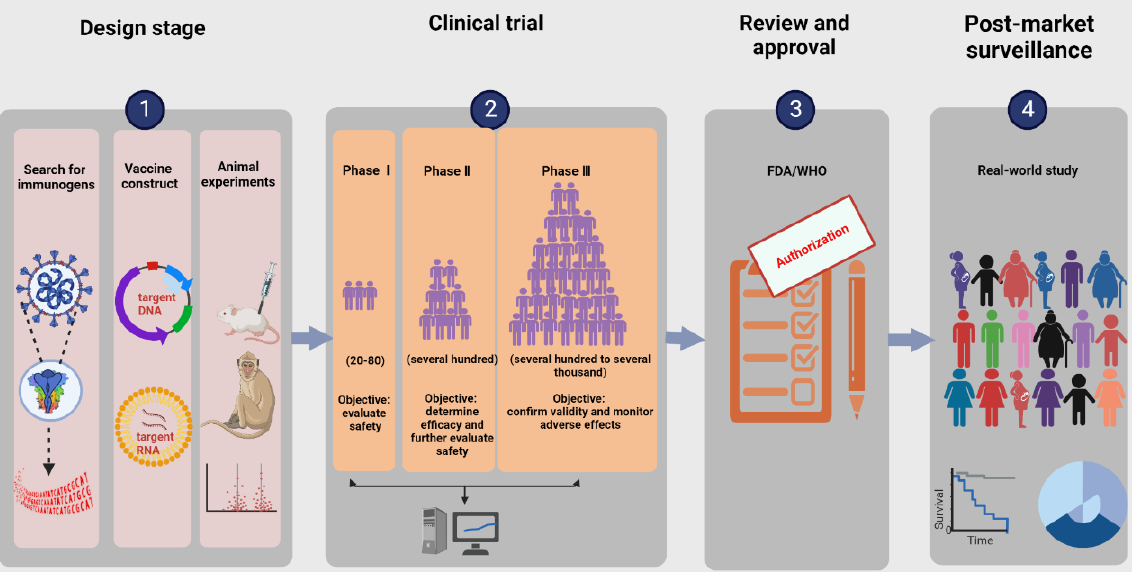
Figure 1. Illustration of the research and development process for nucleic acid vaccines. The proce- dure involves an early design stage, clinical trial stage, review and approval stage, and post-market surveillance. The early design stage generally consists of searching for immunogens, designing vaccine structures, and determining toxicological effects and immune effects in animal models. The clinical trials mainly include phases I–III, targeting primarily practical applications to provide definitive evidence for the safety and efficacy of